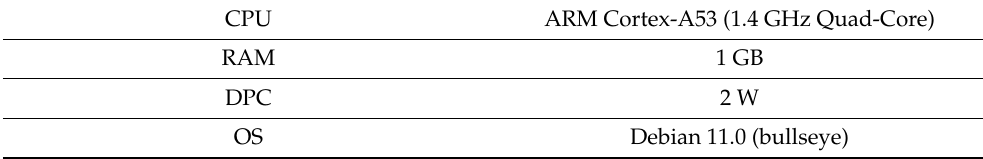
Table 1. Spec of Raspberry Pi 3 Model